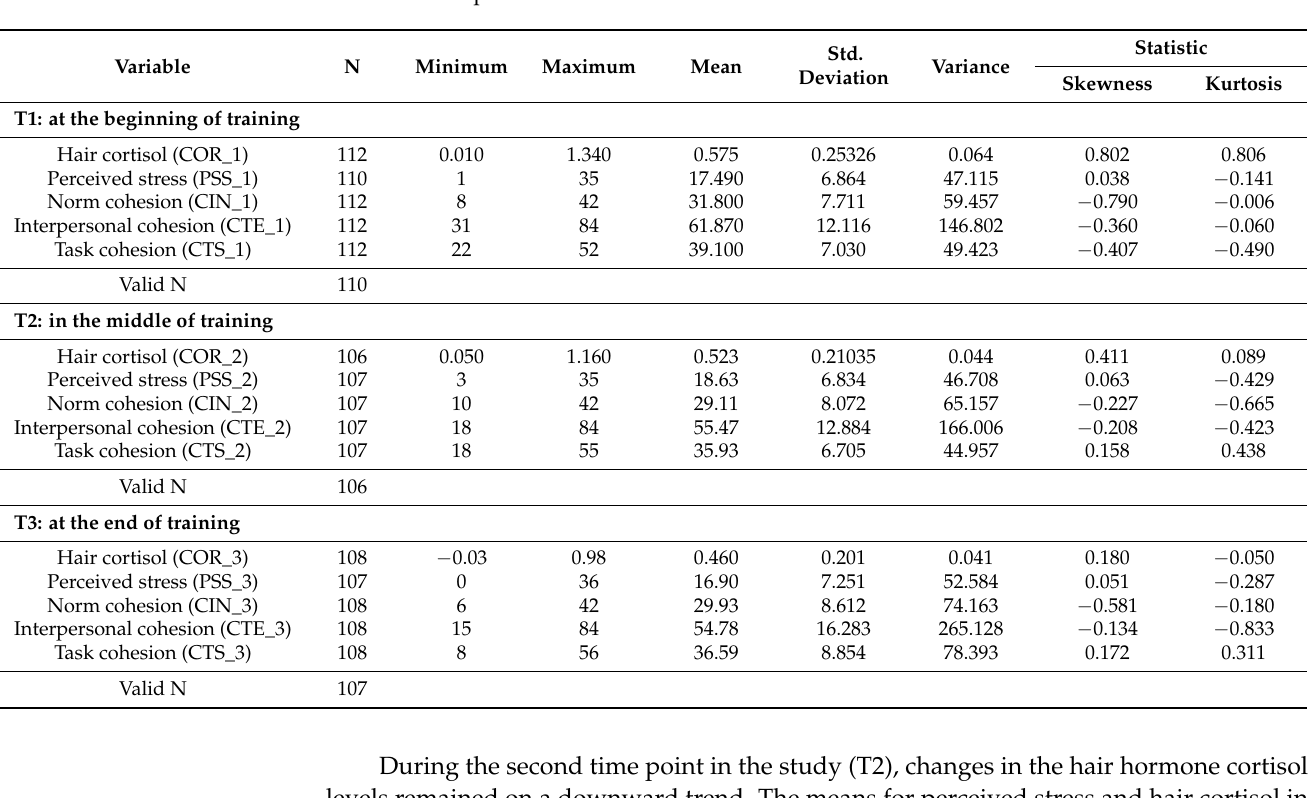
Table 2. Descriptive statistics for variables.